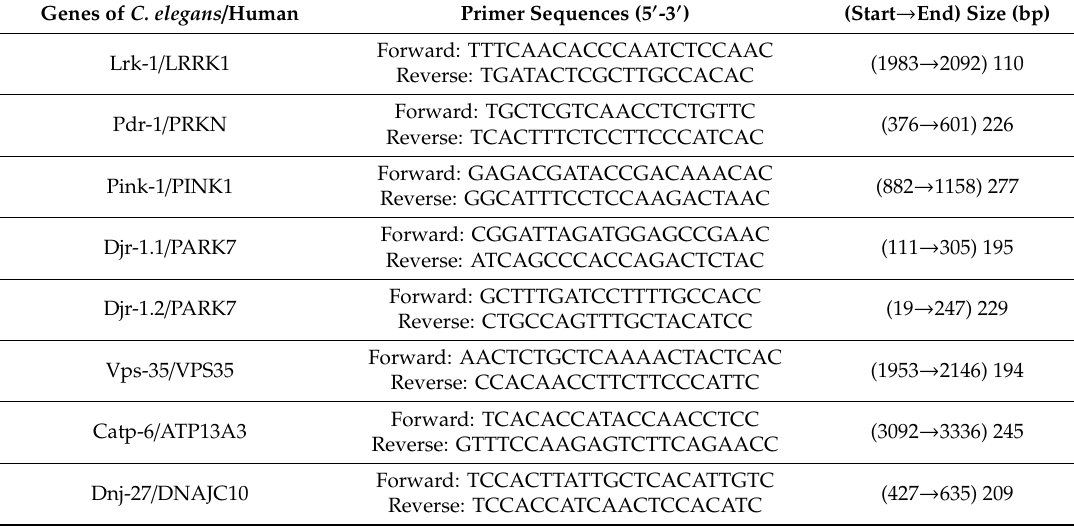
Table 1. Primers for real time